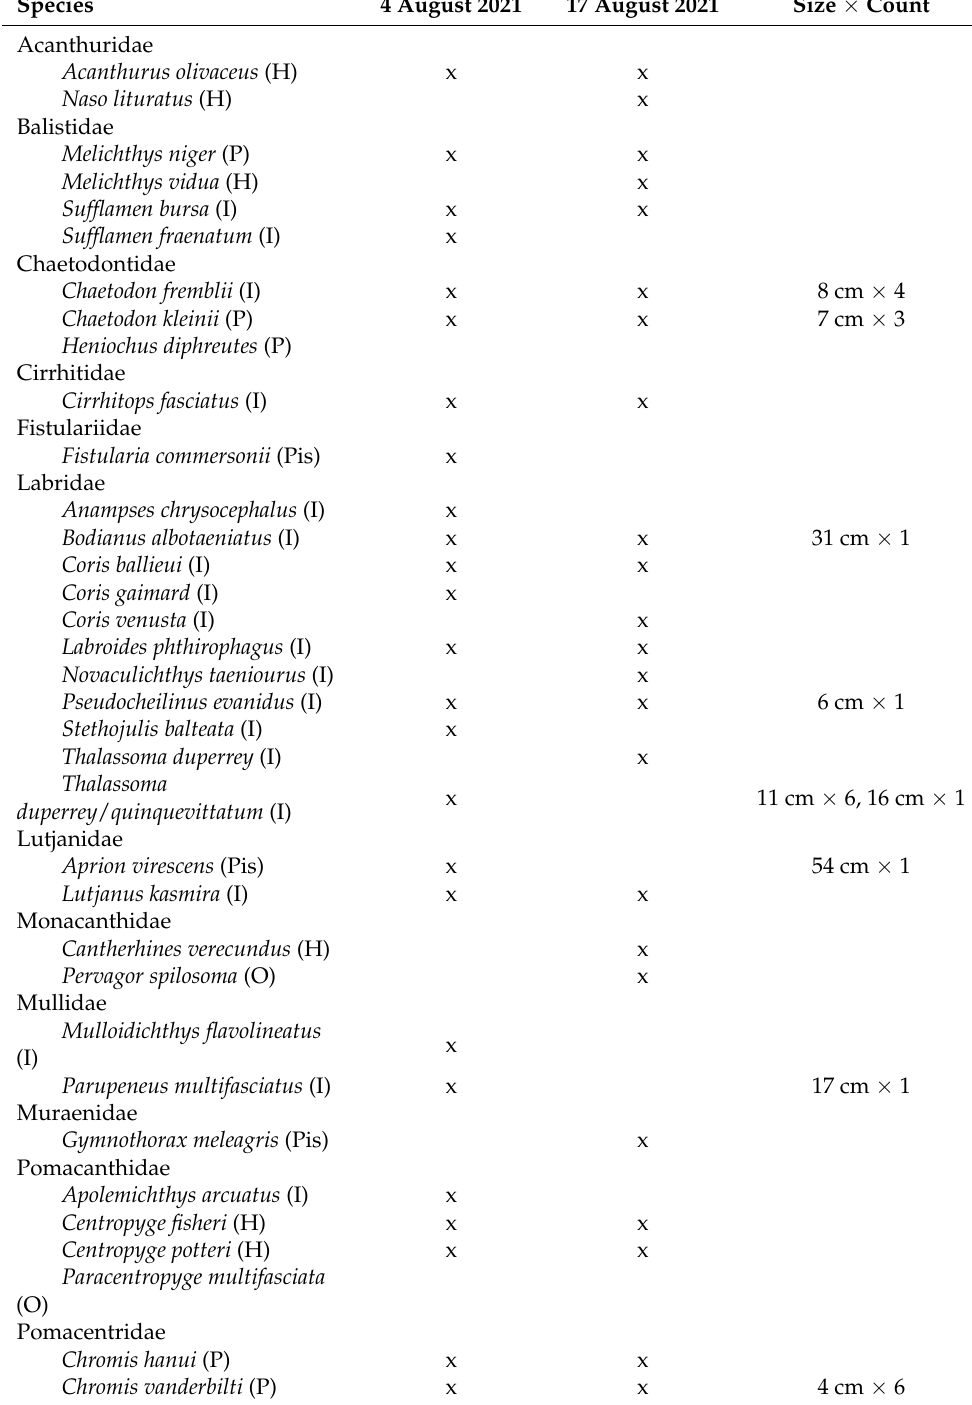
Table A1. Species of reef fish that were present during the surveys on 4 August 2021 and 17 August 2021. Trophic categories are listed in the parentheses: H—herbivore, I—invertivore, O—omnivore, P—planktivore and Pis—piscivore. The “x” denotes presence. Species with size and count data were on the belt transect on August 4, while all other species were in the area but not on the